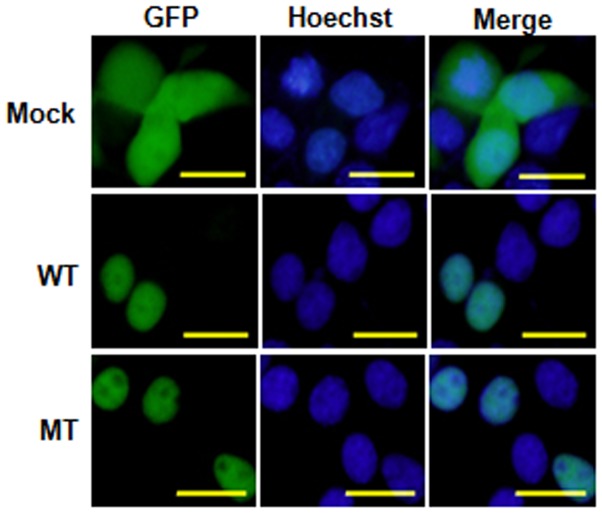
Expression and nuclear localization of p.Y5D mutant.HEK293T cells were transiently transfected with empty vector (Mock), wild-type (WT) or mutant (MT) pEGFP-C3-Sf1 expression vector. The nuclei were counterstained with Hoechst33342 (blue). Scale bars = 10 um.